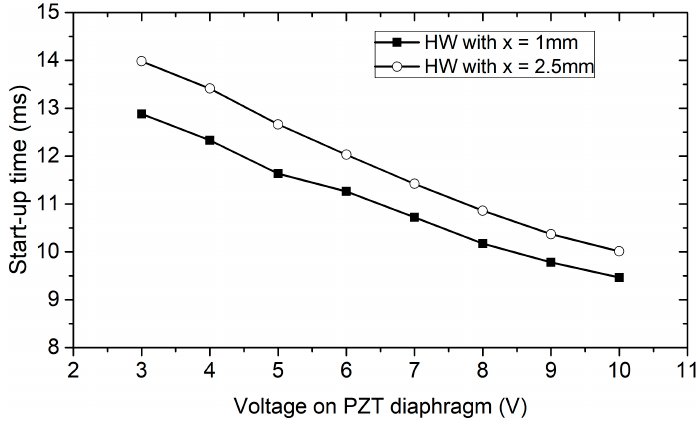
Figure 9. Hotwire voltage changes between gold hotwire and tungsten hotwire and the time-resolved data between actuating voltage and output voltage. The data corresponding to the gold hotwire was independently added to the same x -axis for clarification.